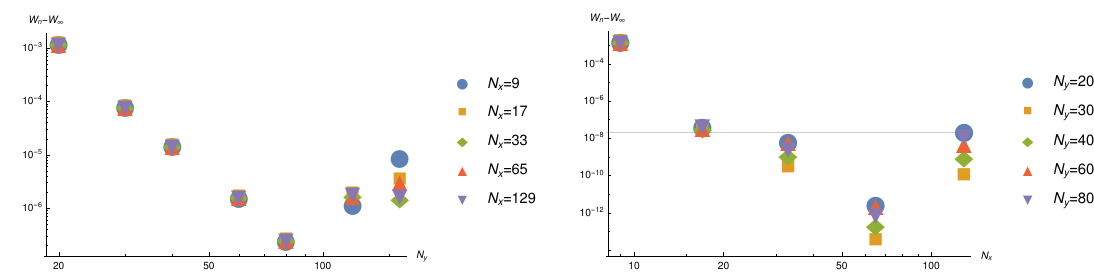
Figure 11 . Accuracy of the thermodynamic potential depending on the size of grid in holographic ( N y ) and spacial ( N x )